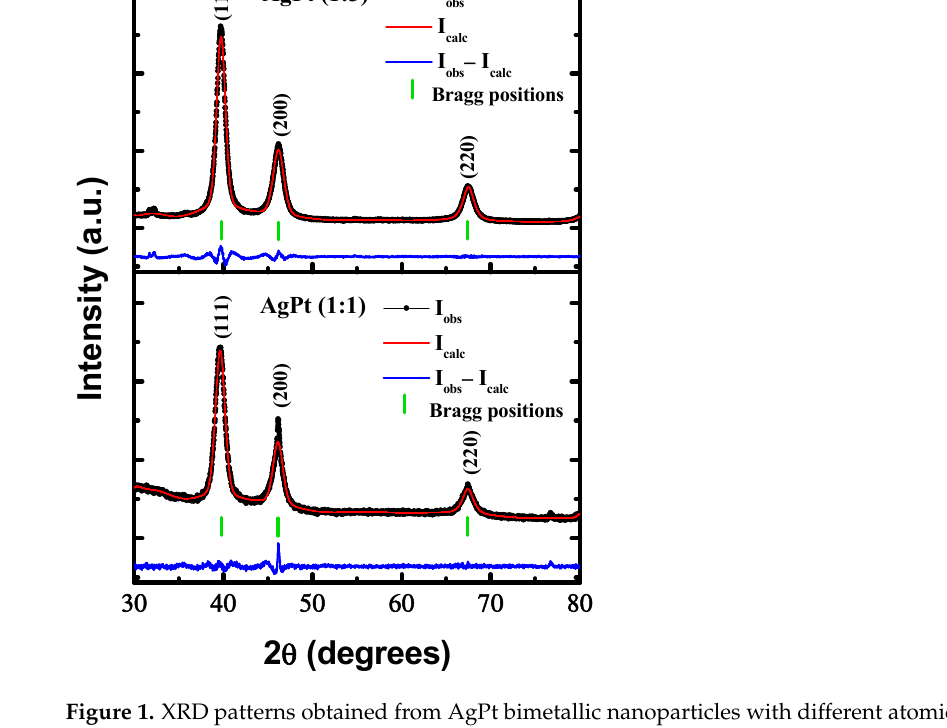
Figure 1. XRD patterns obtained from AgPt bimetallic nanoparticles with different atomic ratios.